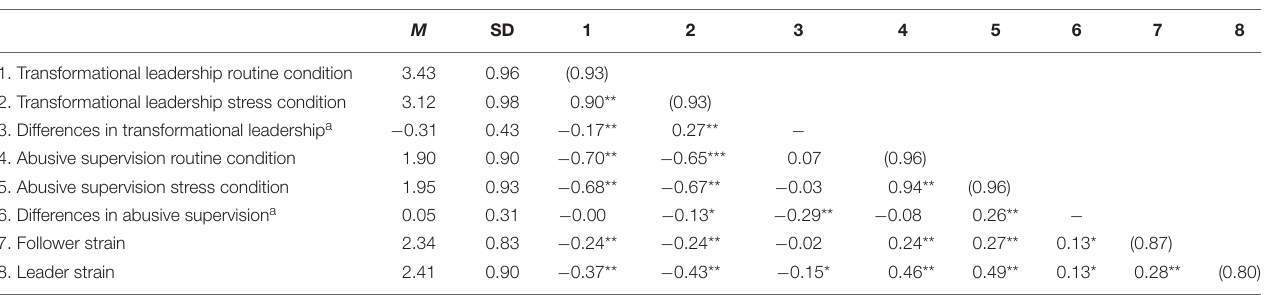
TABLE 1 | Relationships between transformational leadership, abusive leadership, leader and follower strain.